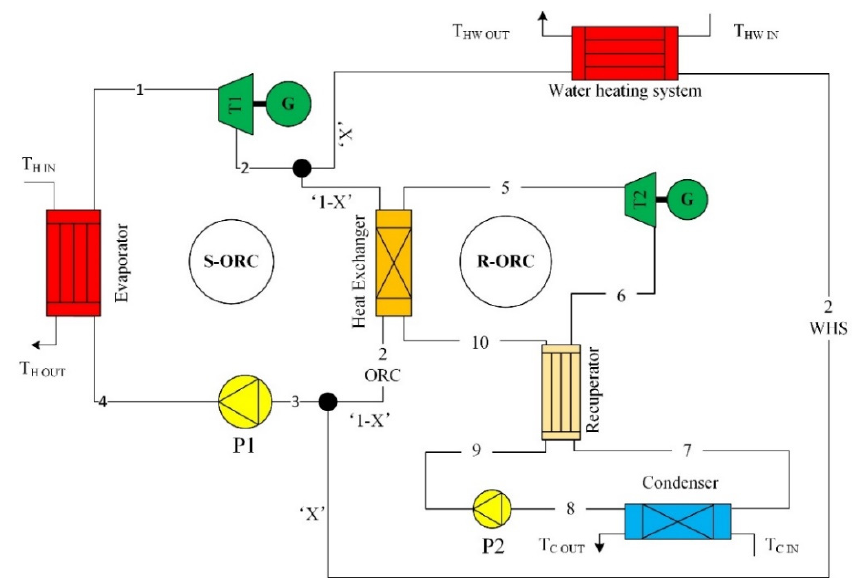
Figure 1. Schematic of dual ORC integrated with WHS.